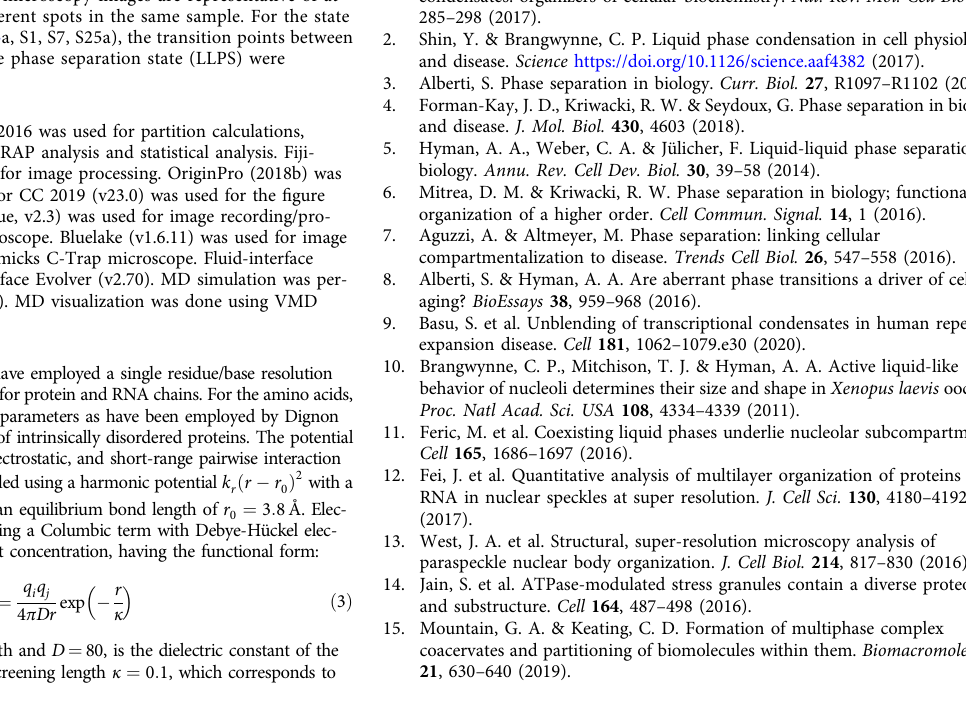
Figure 1b, c: n = 60 for partition and n = 3 for diffusion coef fi cient. Figure 1k: n = 100 for EWS PLP partition, n = 50 for FUS PLP partition and n = 75 for BRG1 LCD partition. Figure 4c: n = 25 for contact angle measurements of each droplet type ( θ PLP and θ RRP ). Figure 5b: n = 60 for partition and n = 3 for diffusion coef fi cient measurements. All statistical measurements were done on the same sample for each distinct experimental condition. For reproducibility, all the main-text fi gures (Figs. 2a, c, 3a, c, 3e, f, 3h – j, 4b, 5f, g) that contain microscopy images are representative of two independent sample replicates. For Figs. 1g – i and 5c in the main-text, the reported images are representative of a large set of images from different spots in the same sample. For FRAP measurements (Figs. S3, S23), the microscopy images are representative of at least three FRAP events from different spots in the same sample. For the state diagram measurements (Figs. 1a, 5a, S1, S7, S25a), the transition points between the mixed state (no LLPS) and the phase separation state (LLPS) were reproduced twice for each